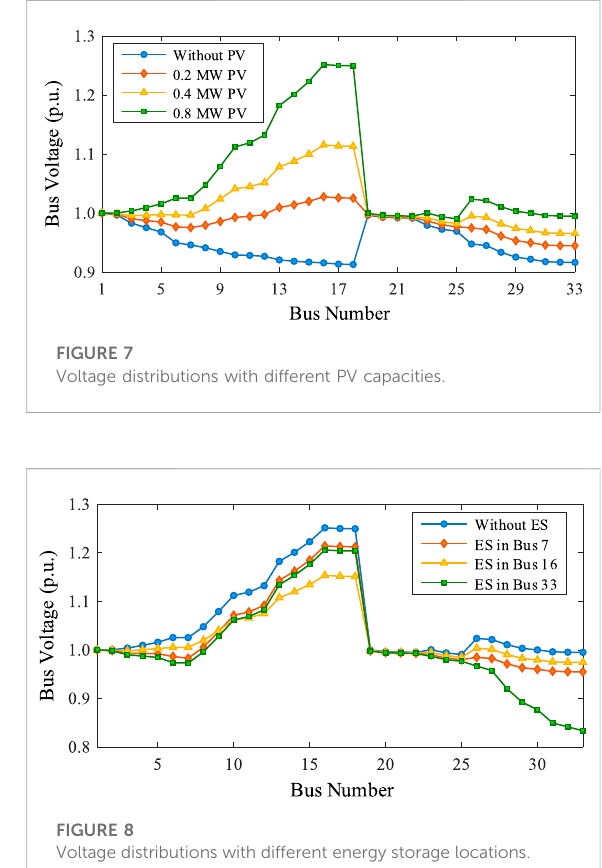
FIGURE 8 Voltage distributions with different energy storage